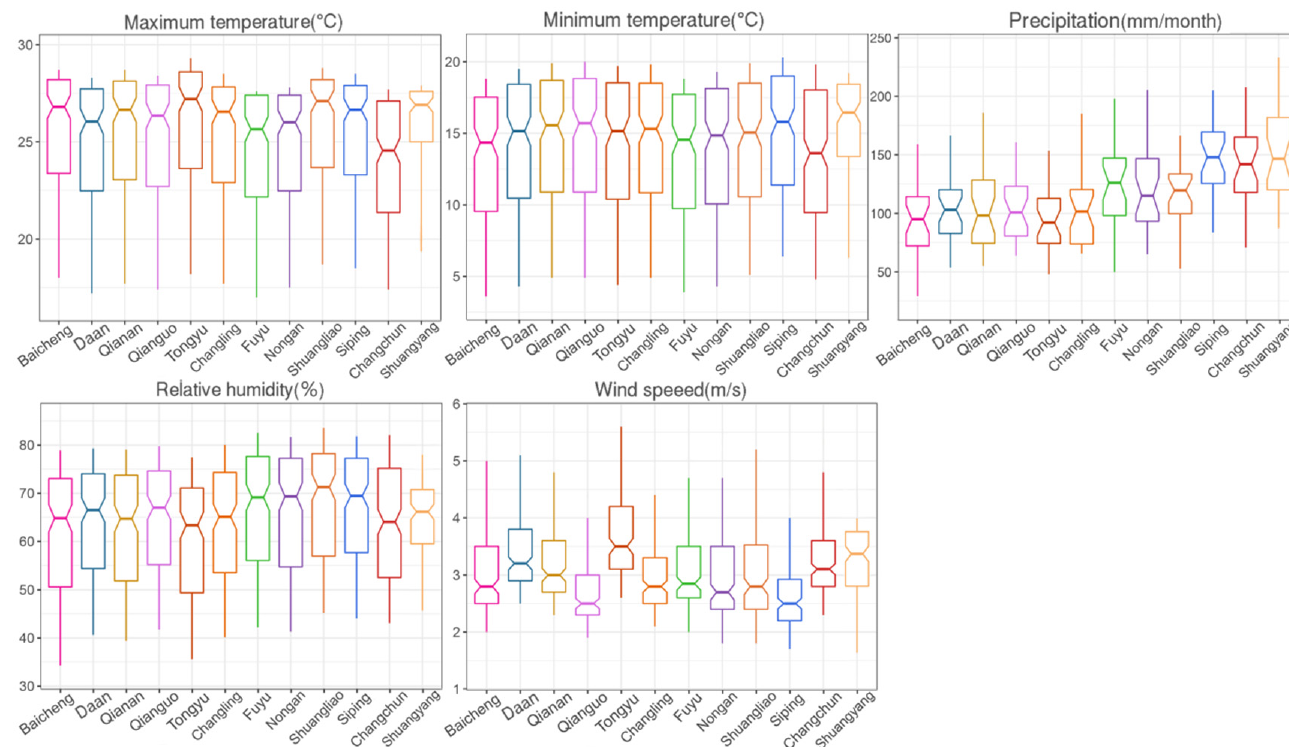
Figure 3. Climatic characteristics in midwestern Jilin Province for 1980–2020.